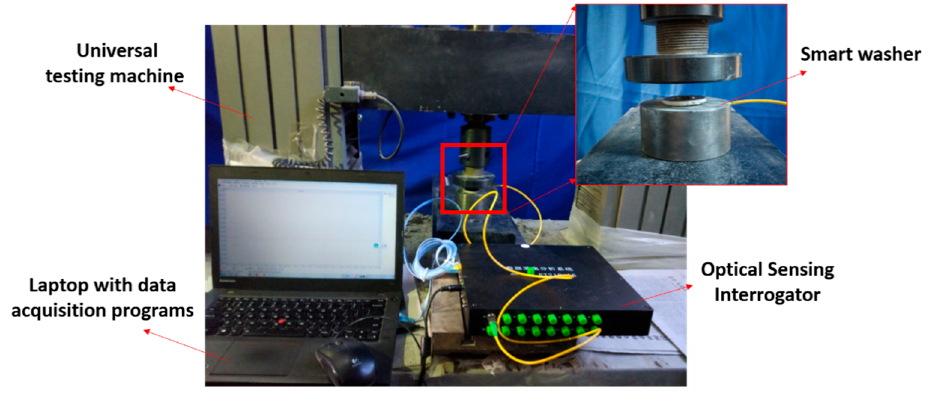
Figure 4. Calibration test of the FBG smart washer.